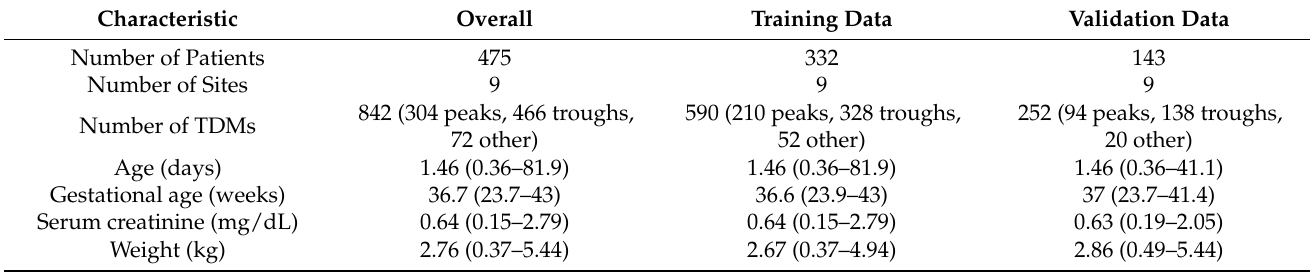
Table 1. Patient characteristics of the overall data set, the training data set for model re-fitting, and the validation data set for re-fitted model evaluation. Values are median